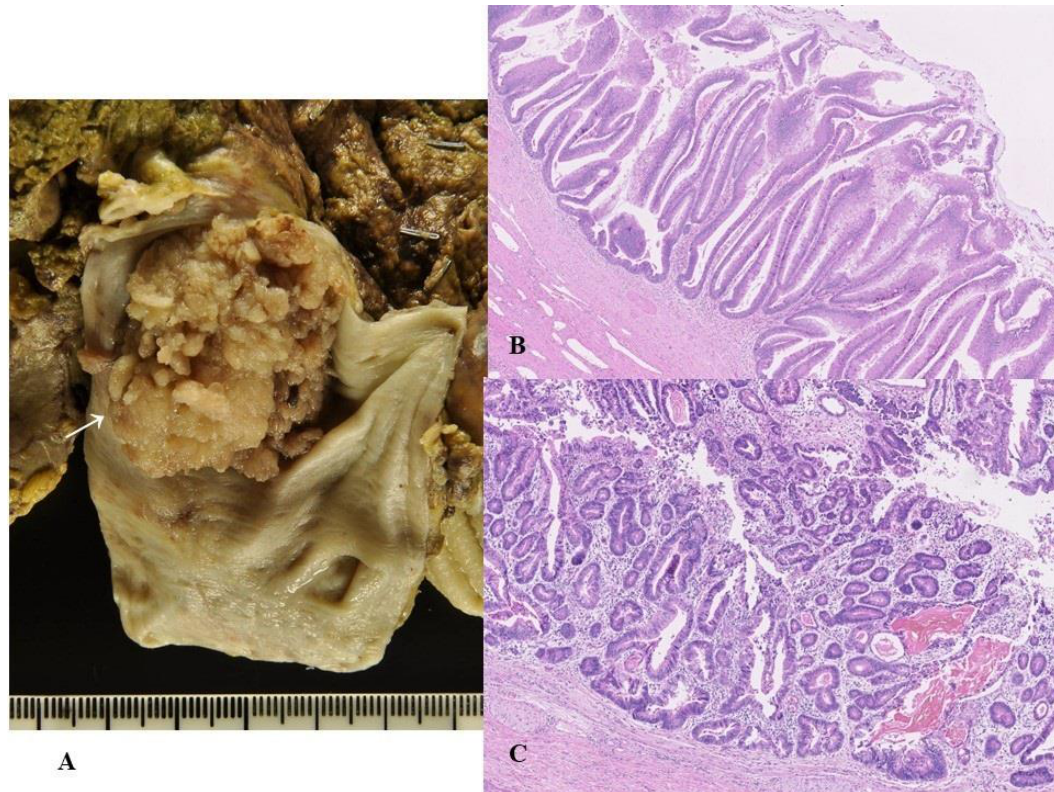
Figure 2. Intraductal papillary neoplasm of bile duct (IPNB) ( A ) Gross features. Papillary neoplasm in the dilated extrahepatic bile duct (arrow). ( B ) Villous neoplasm with fine fibrovascular stalk and low-grade dysplastic changes. Type 1 IPNB of intestinal subtype (villous/papillary predominant type). Intrahepatic large bile duct. ×100. HE staining. ( C ) Tubular neoplasm with irregular structures and high-grade dysplastic changes. Type 2 IPNB of intestinal subtype (tubular predominant type). ×100. HE staining.